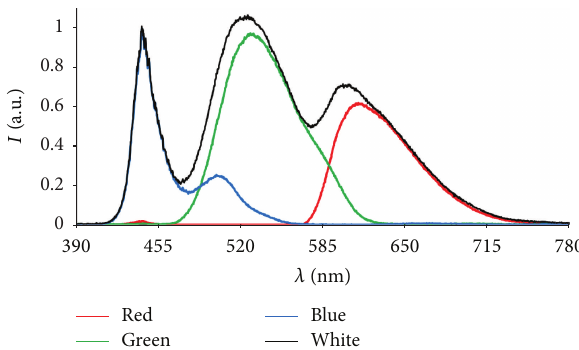
Figure 5: Intensity spectra of RGB colors and white of an LED monitor (Flatron IPS235P, LG Electronics Inc., Seoul, South Korea) measured with a spectrometer (HR4000, Ocean Optics, Dunedin,